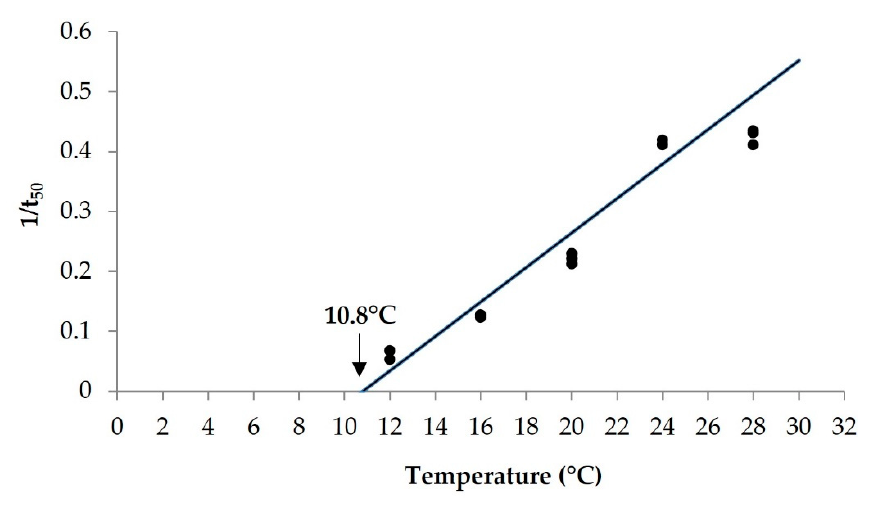
Figure 2. Estimated base temperatures (T b ) for the germination of Echinochloa crus-galli . The solid line represents the linear regression line, and the points represent the inverse value of the time necessary to reach 50% of germination (1/t 50 ) estimated for the single replicates. The estimated value of the base temperature is the intersection of the regression line with the X-axis, T b = 10.8 ± 0.27; y = 0.0288x − 0.3119, and R 2 =